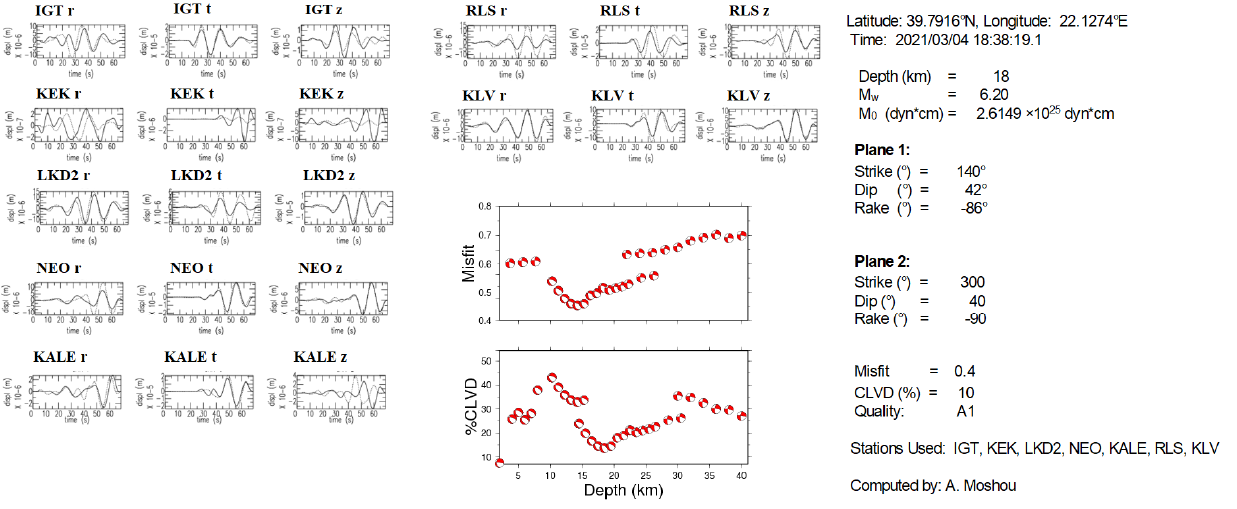
Figure 10. Inversion results for the second major mainshock of 4 March 2021 (18:38:19.19 UTC). To the left of the misfit/CLVD diagrams, observed and synthetic displacement waveforms (continuous and dotted lines, respectively) are shown at the inverted stations for the radial, tangential and vertical components. The solution’s summary and the fault plane solution as a lower hemisphere equal-area projection are depicted in the right part of the figure.